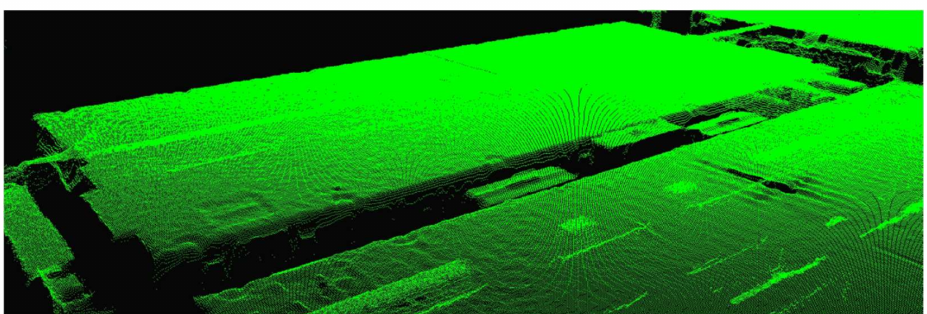
Figure 17. Outlined corner of a battery module ( red ).